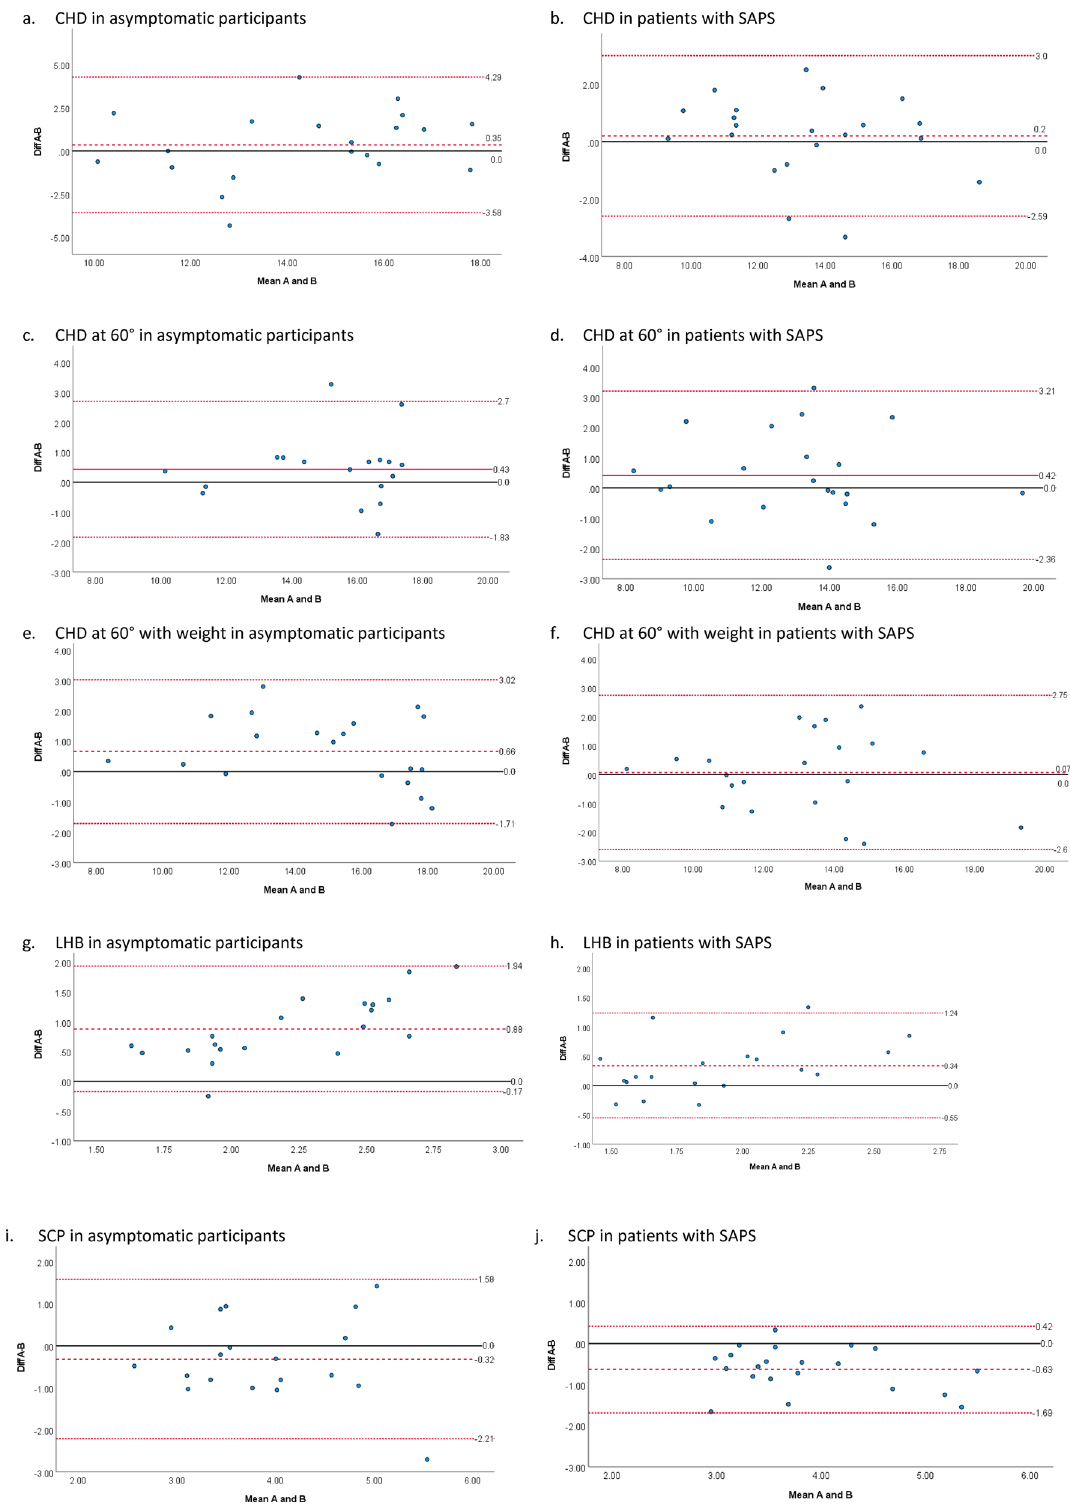
Figure 6. Bland–Altman plots for inter-rater reliability. Color of the lines: dashed red line: mean difference, dotted red line: limits of agreement of the mean difference, black line: perfect agreement (difference between A and B = 0). CHD coracohumeral distance, Diff difference, LHB long head of biceps, SAPS subacromial pain syndrome, SCP subscapularis